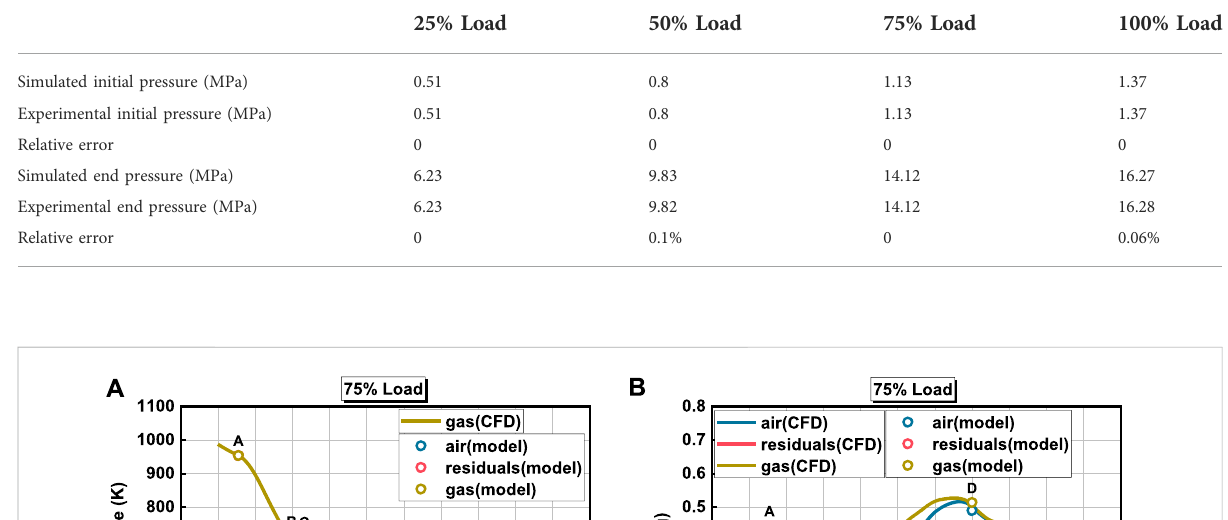
TABLE 4 Comparison of the simulation and experimental cylinder pressure relative deviations under different conditions.